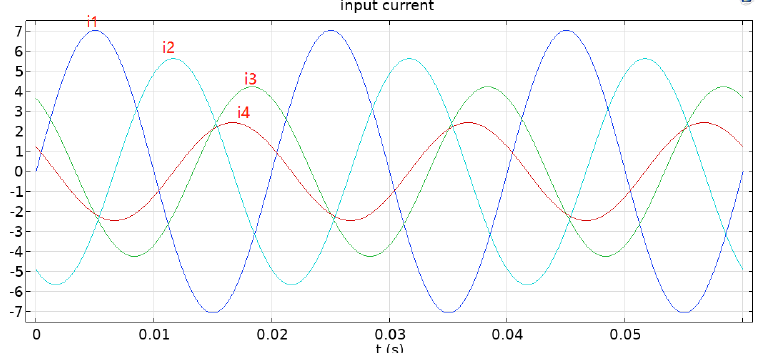
Figure 4. Three-phase four-wire system input current waveform.